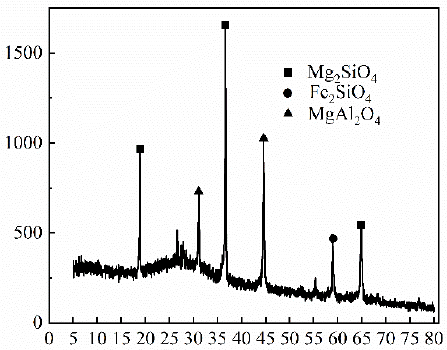
Figure 2. XRD of ferrochrome slag.